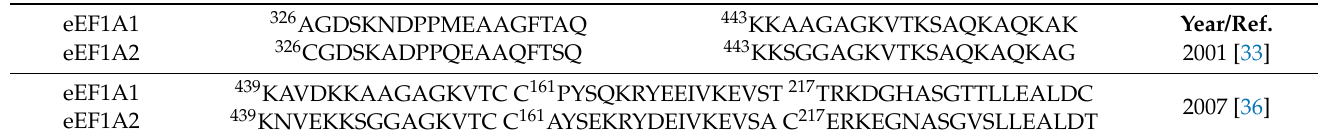
Table 1. Peptide sequences used to generate specific antibodies against eEF1A1 and eEF1A2 a . eEF1A1 326 AGDSKNDPPMEAAGFTAQ 443 KKAAGAGKVTKSAQKAQKAK Year/Ref. eEF1A2 326 CGDSKADPPQEAAQFTSQ 443